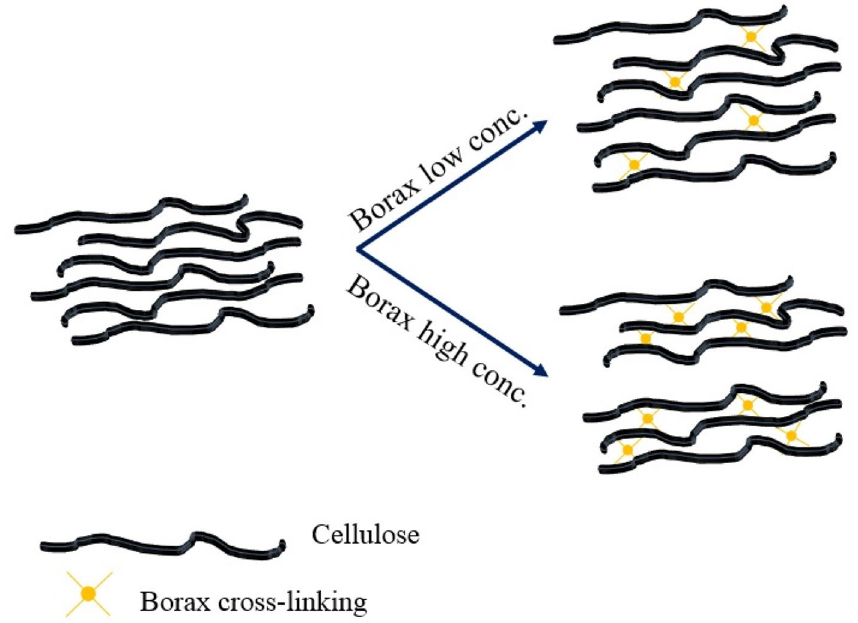
Figure 7. Schematic illustration of cross-linking reaction between cellulose chains at a low and high concentration of borax.